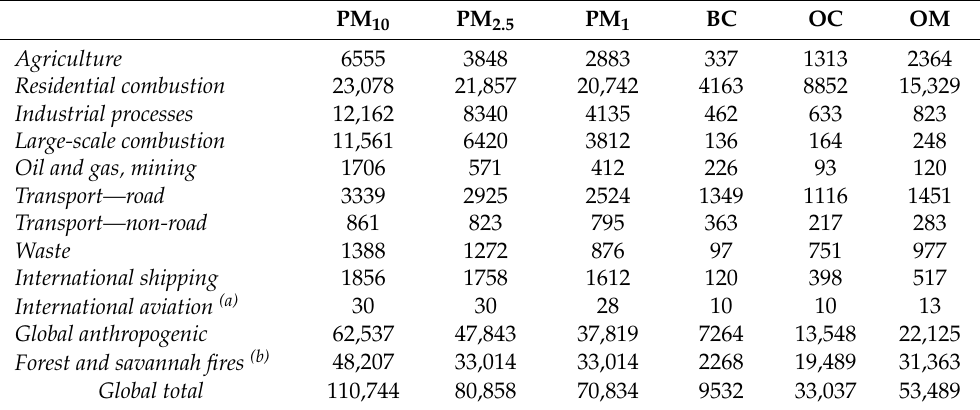
Table 1. Sectoral emissions of particulate matter in 2010, ECLIPSE V5a, Gg year − 1 [30]. (a) Values are middle-of-the-range estimates based on the ranges reported in [31,32], and based on global fuel consumption and ranges of emission factors [33]. (b) GFED3.1 [34,35] without agricultural waste burning that is included based on GAINS [36] estimates in category “Agriculture”; PM 10 value based on TPM (total particulate matter); PM 1 not available in GFED—here assumed equal to PM 2.5 . PM